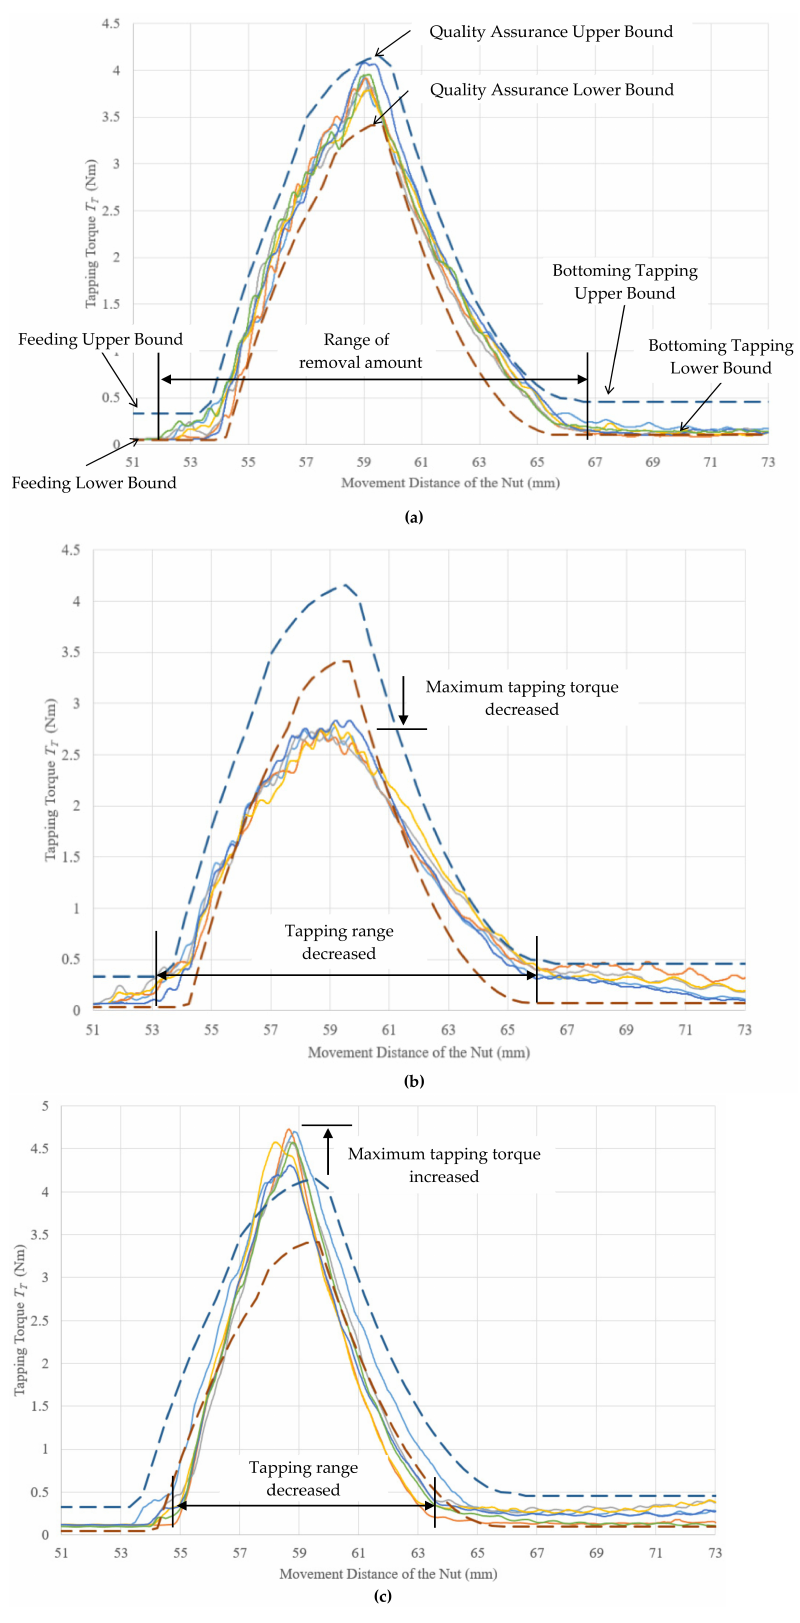
Figure 11. Quality assurance module for AISI-4140 and 14 m/min: ( a ) JIS I range; ( b ) JIS II range; ( c ) tapper wear. (The solid line is the tapping torque measured by real-time monitoring. The dotted line is the calculation of the quality monitoring